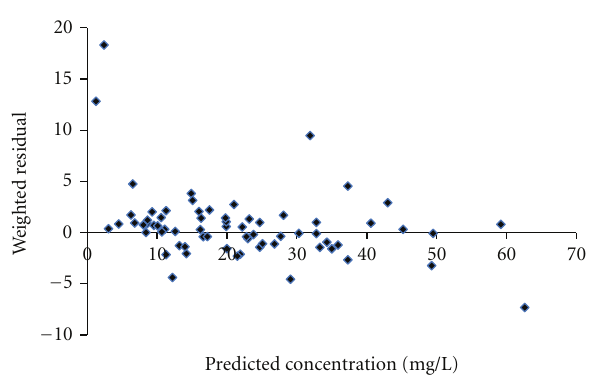
Figure 5: Scatter plot of predicted concentrations against weighted residuals of validation